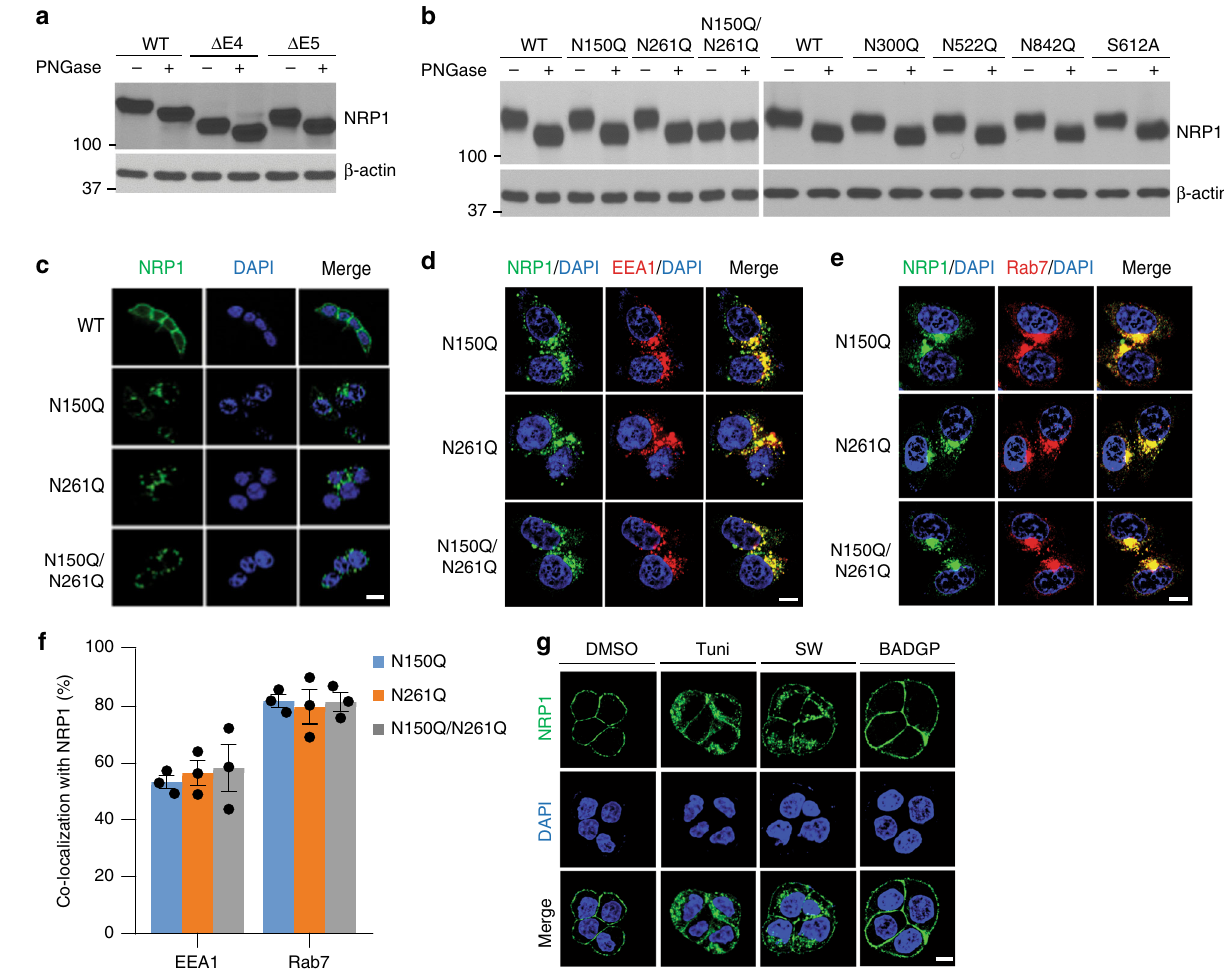
Fig. 4 Defect in N-glycosylation at N150 or N261 in NRP1 leads to increased endocytic traf fi cking. a , b The lysates of HCT116 cells with stable a or transient b expression of NRP1-WT or the indicated NRP1 splice variants or mutants were treated with or without PNGase, followed by western blot analysis. c Confocal images of NRP1 with DAPI staining in HCT116 with stable expression of NRP1-WT or its mutants. Scale bars, 10 µ m. d , e Confocal images of NRP1, EEA1, Rab7 and DAPI staining in HCT116 cells with stable expression of NRP1-WT or its mutants. Scale bars, 10 µ m. f The percentage of co- localization between NRP1 and EEA1 or Rab7 as shown in d and e is presented as mean ± s.e.m. ( n = 3 independent experiments). g Confocal images of NRP1 with DAPI staining in HT29 cells with stable expression of NRP1-WT that were treated with tunicamycin (10 μ gml − 1 ), swainsonine (5 μ gml − 1 ), BADGP (2 mM) or DMSO as control for 24 h. Scale bars, 10 µ